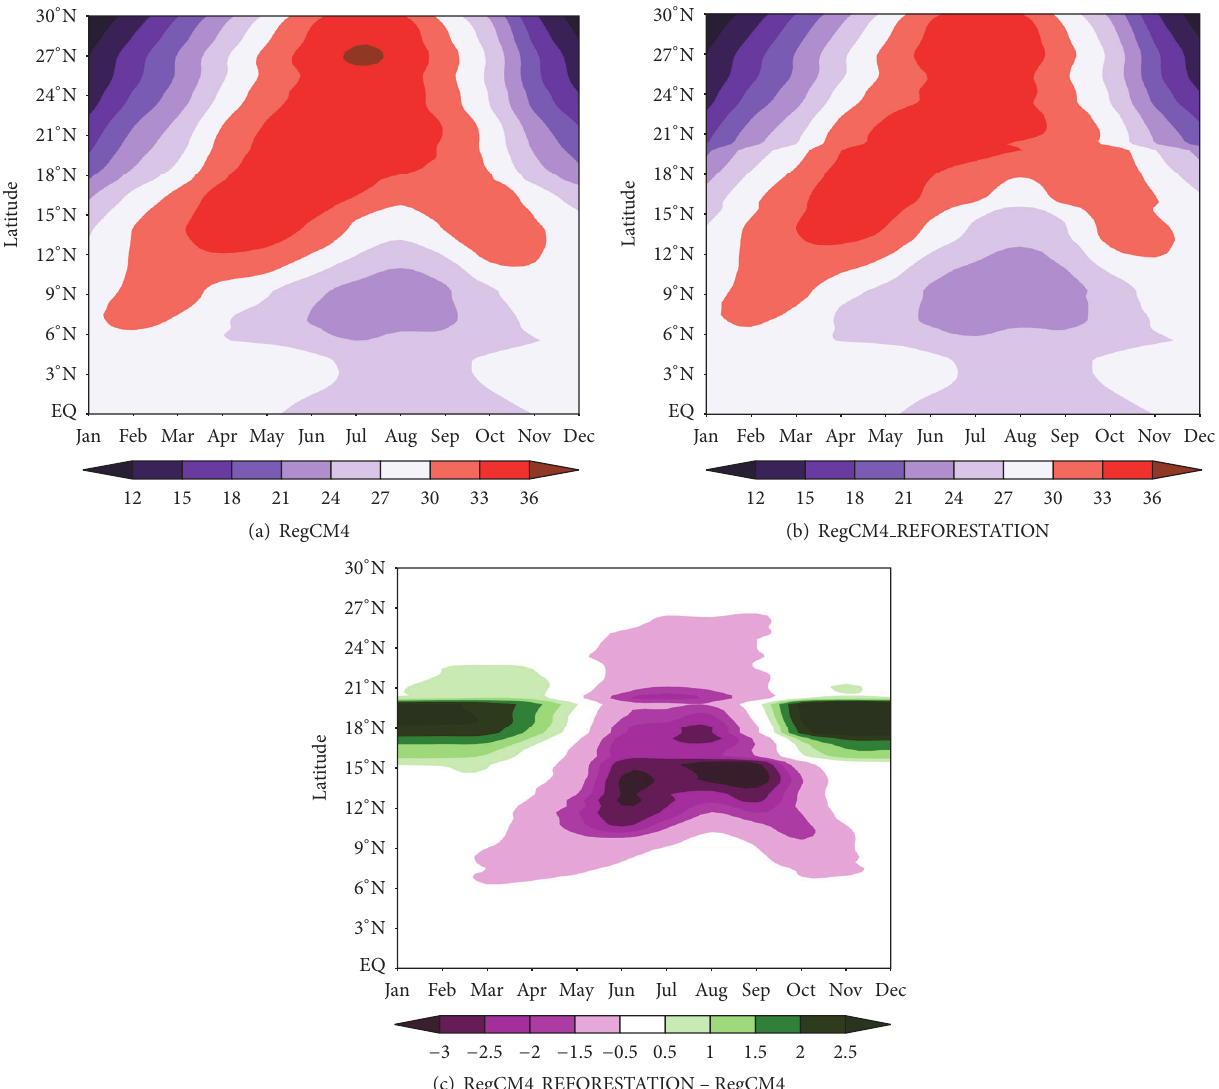
Figure 7: Hovmo¨eller diagram of surface temperature averaged between 10 ∘ W and 10 ∘ E and from 2003 to 2009 for both runs and their